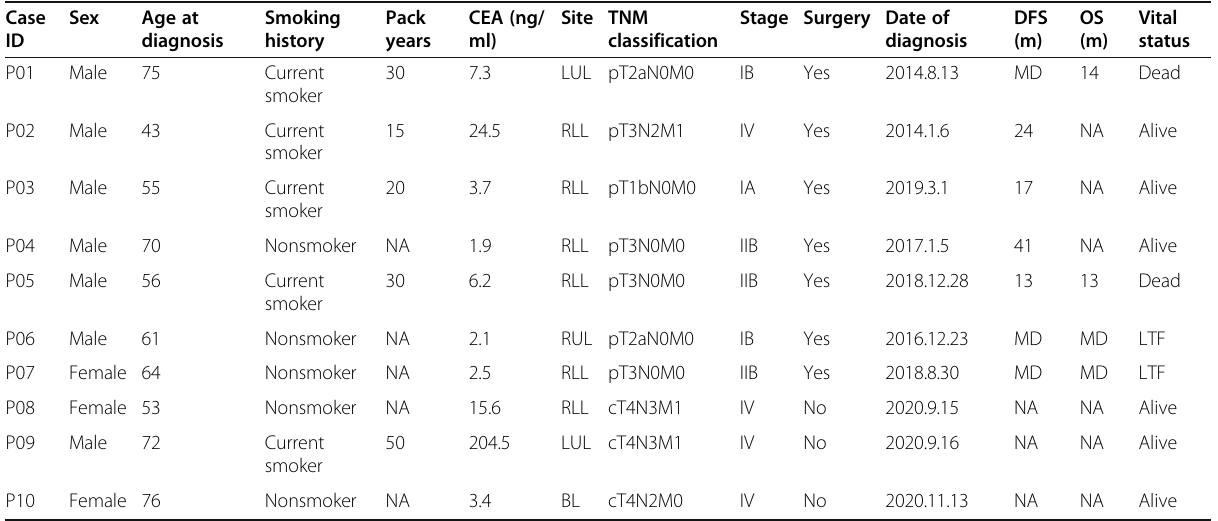
Table 1 Demographic, clinical and radiological characteristics of the PEAC patients